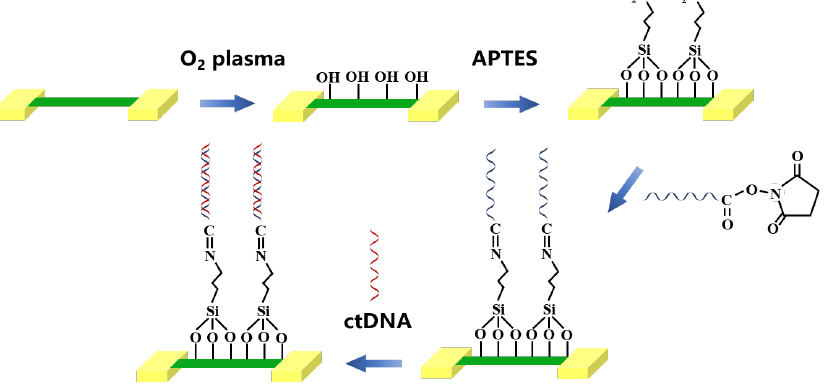
Figure 6. Preparation of SiNW array FET biosensor for tumor marker ctDNA detection (Adapted with permission from Ref. [44]. 2021, Li et al).